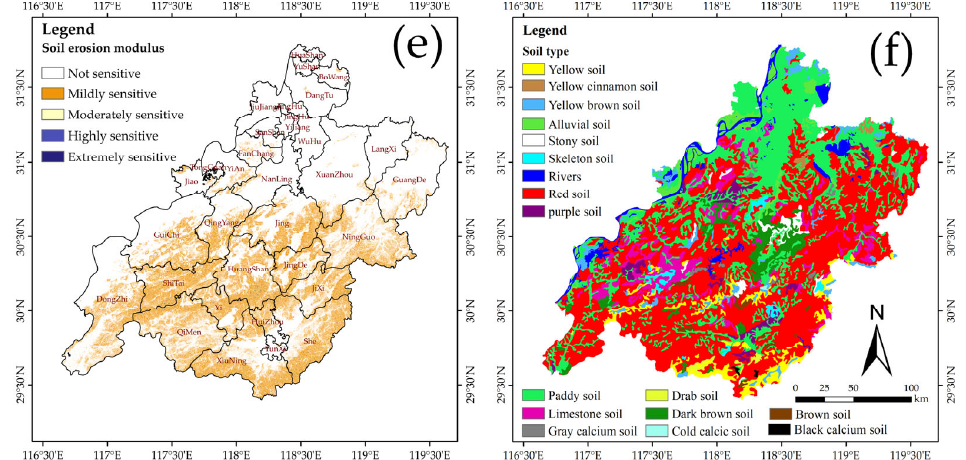
Figure 5. Spatial distribution pattern of ecological sensitivity factors in the study area; ( a ) shows land use; ( b ) shows the elevation; ( c ) shows the slope; ( d ) shows NDVI; ( e ) shows the degree of soil erosion; ( f ) shows the soil type.